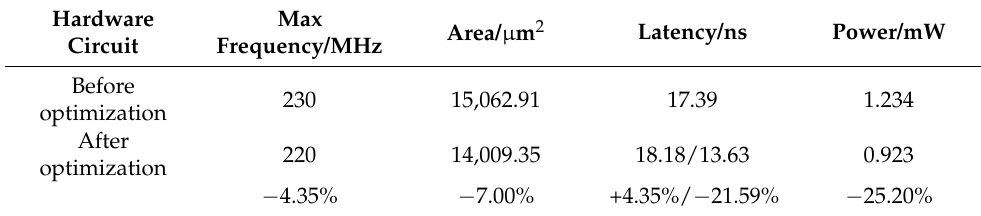
Table 6. Hardware comparison before and after optimization.